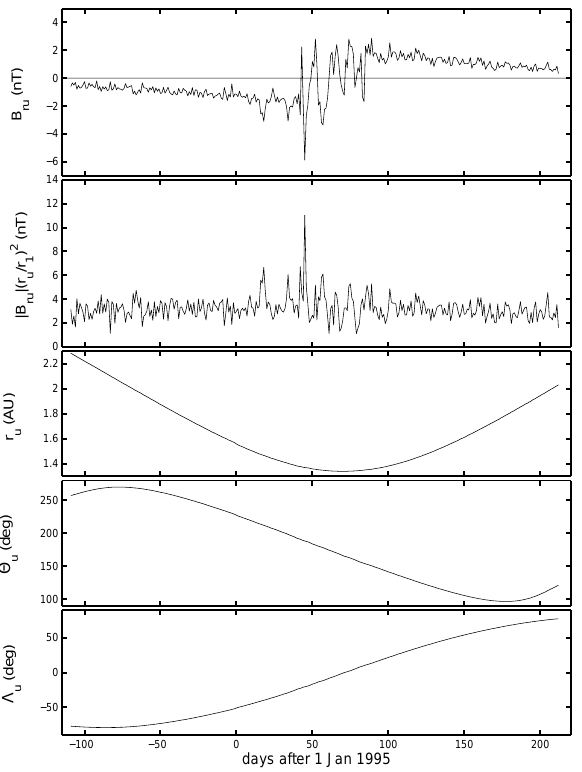
Fig. 6. Ulysses and near-Earth IMF data during the first perihelion pass. From top to bottom: the solar wind propagation lag L from ( r 1 ,2 u ,3 u ) to (r u ,2 u ,3 u ) ; the radial solar wind speed V r ; the normalised radial field magnitude at r = r 1 = 1AU, | B ru | (r u /r 1 ) 2 at time (t u − L) , where t u is the observation time at Ulysses; the radial field magnitude observed near Earth | B r 1 | . Thin lines show daily means, thick lines are 27-day running